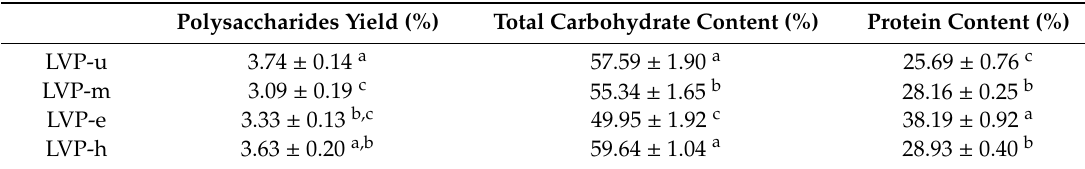
Table 1. Yields and chemical compositions of LVPs extracted by di ff erent methods.